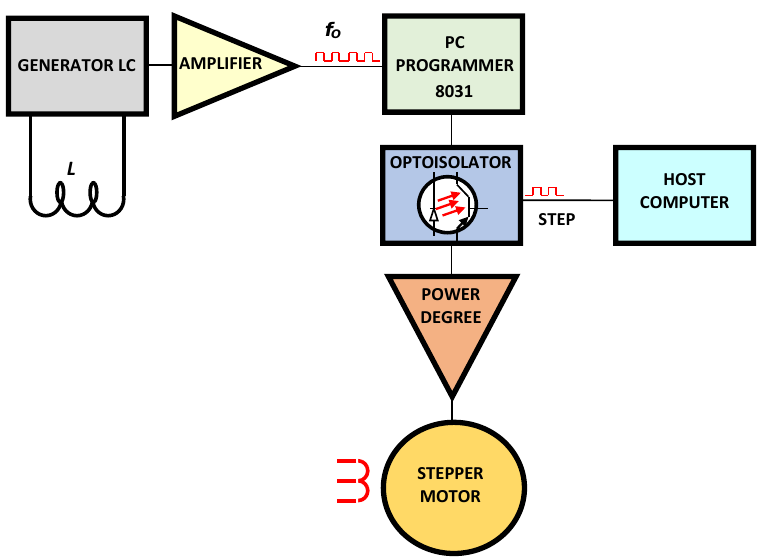
Figure 5. A schematic diagram of system for control of tool-electrode feed.